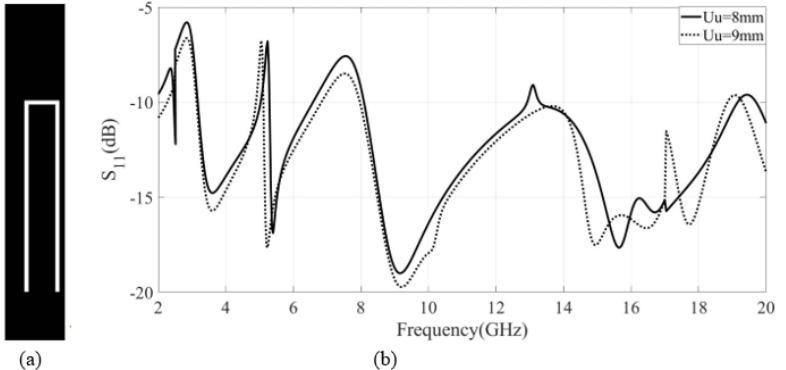
Figure 4. ( a ) Geometry of U u -shaped slot; and ( b ) S 11 parameter with different lengths of an inverted U-shaped slot ( U u = 8 mm, 9 mm) for WLAN band